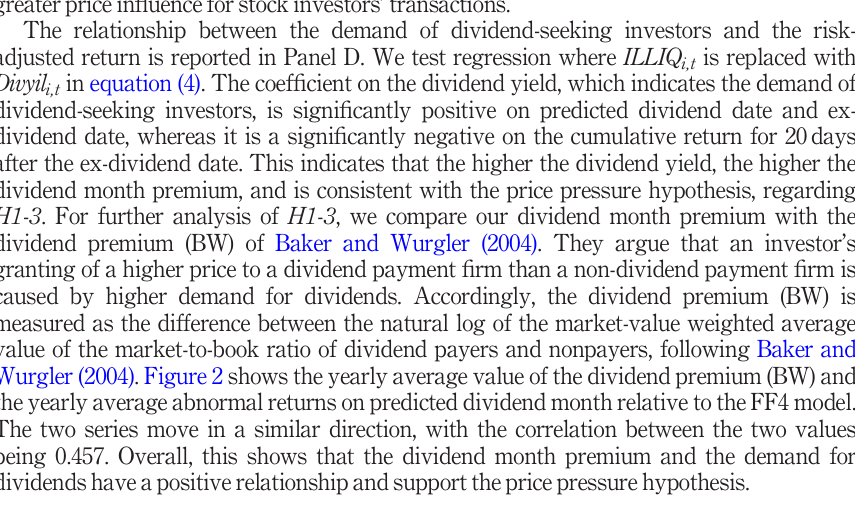
0.40.5 ­0.1­0.0500.050.10.150.20.25 0.100.10.20.3 ­ ­ 0.2